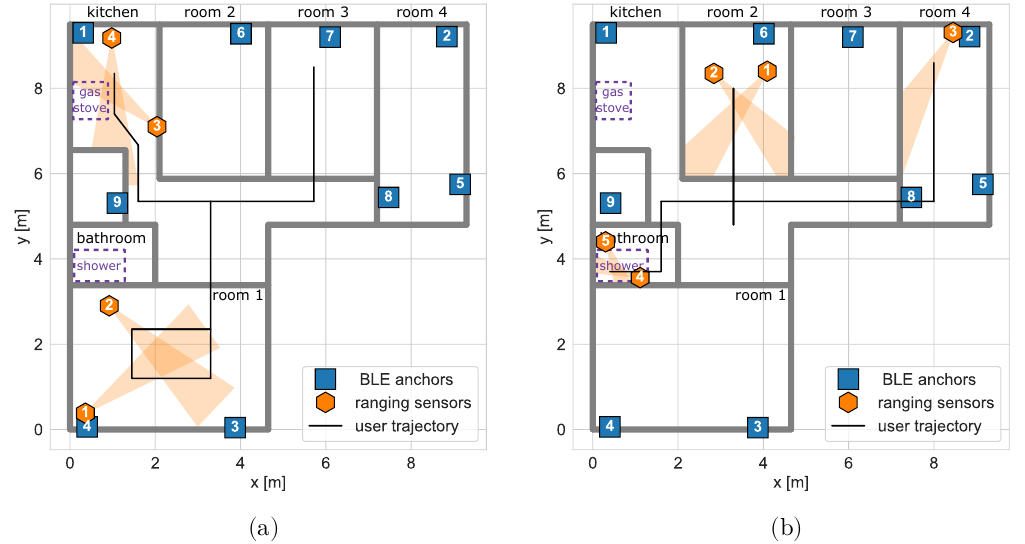
Figure 11. Layout of BLE system infrastructure and laser sensors used in the experiment for: ( a ) test path 1, ( b ) test path